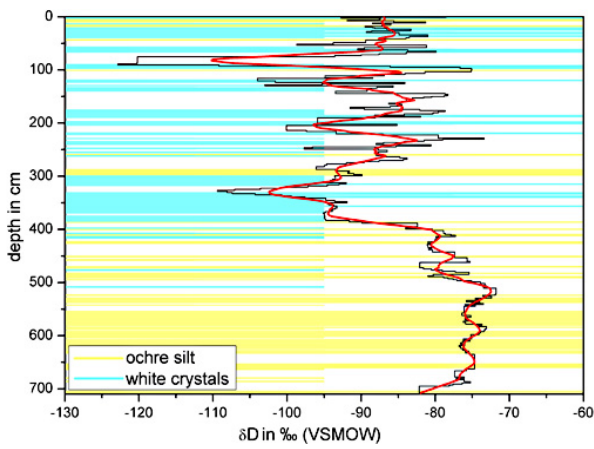
Fig. 7. δ D record of the quasi-continuous 2cm-aliquots superim- posed on the stratigraphy based on the qualitative identification of particles observed in the melted aliquots. The data was transferred onto an equidistant record with a resolution of 0.1cm, where gaps were linearly interpolated before a 25cm-running average of the equidistant data was created (red